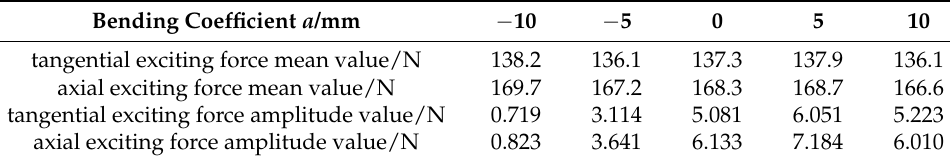
Table 6. Exciting force under near-blockage